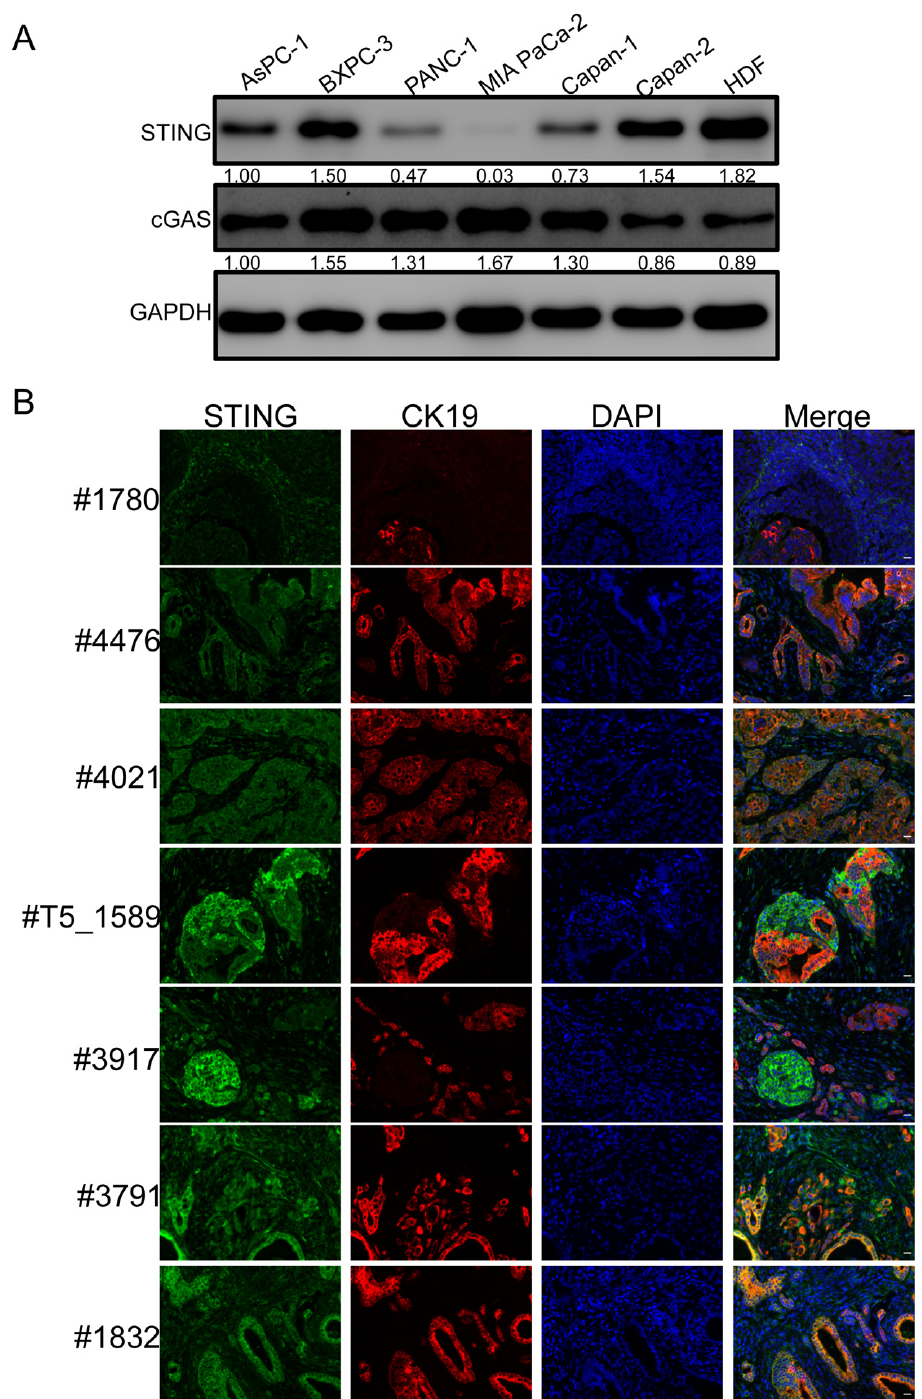
Figure 1. STING is downregulated in PDAC. ( A ) Whole-cell lysates of PDAC and primary HDF cells were immunoblotted using the indicated antibodies. GAPDH was used as a loading control. The protein band intensities were quantified using ImageJ software and denoted below each blot. ( B ) PDAC lesions were stained for STING (Green) and CK19 (Red), and they were counterstained with DAPI. Shown are the staining results of pancreatic lesions derived from seven different patients. Scale bar: 20 µm.